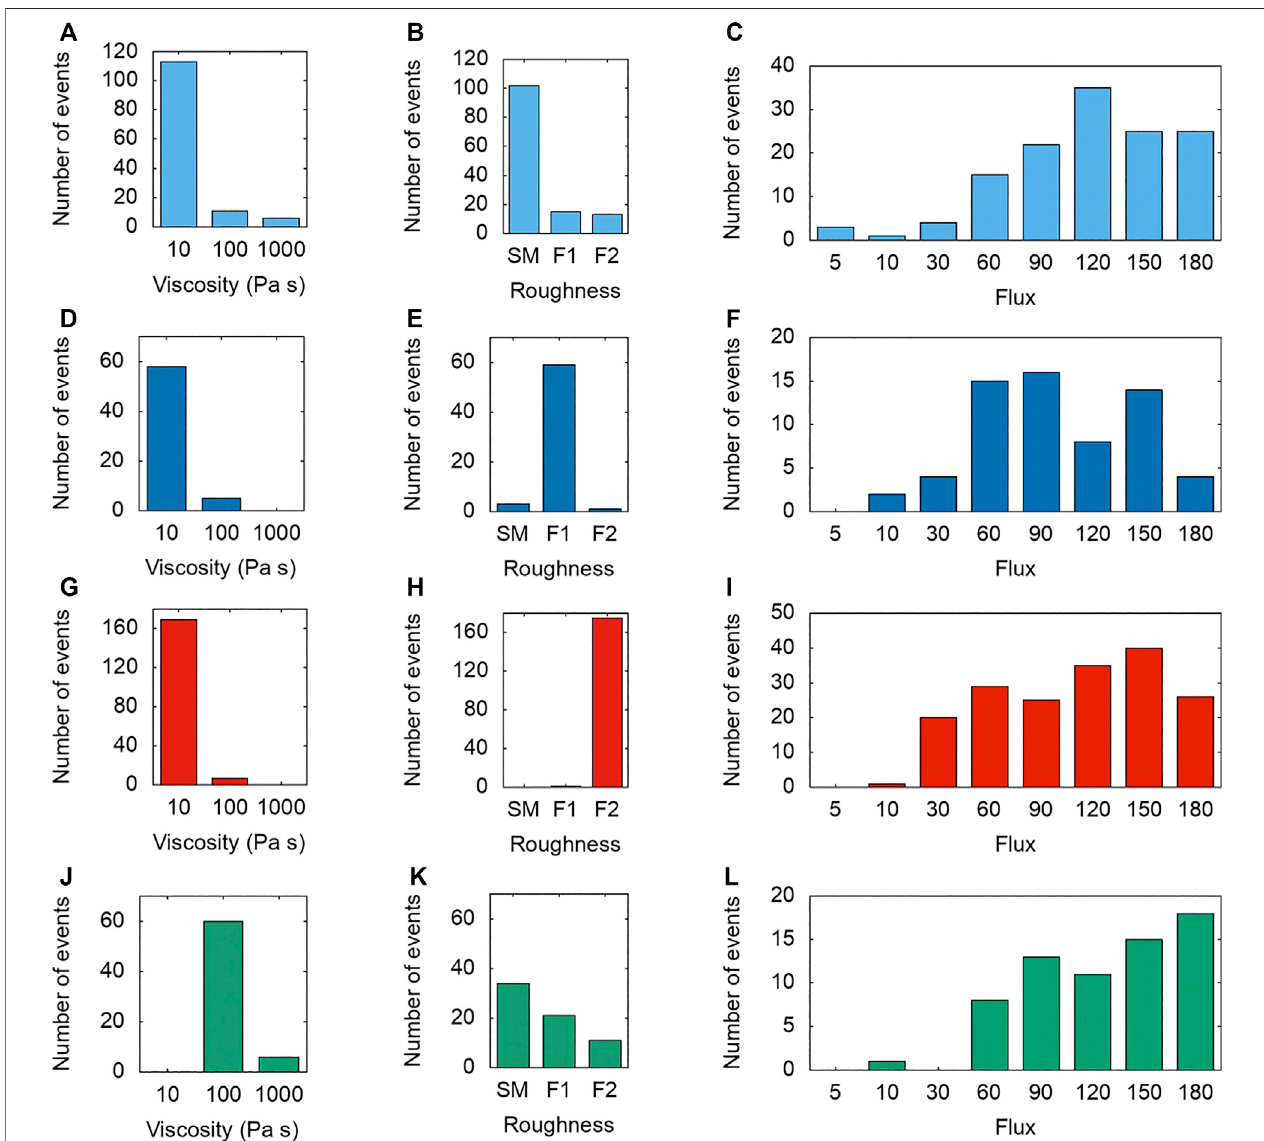
FIGURE 8 | Histograms of the distribution of Cluster 1 (cyan), Cluster 2 (blue), Cluster 3 (red) and Cluster 4 (green) events in the analogue magma viscosity, analogue conduit roughness and fl ux rate classes. Plots (A) , (D) , (G) , and (J) show the distribution of events belonging to the four clusters in the classes of viscosity, expressed in Pa s (B) , (E) , (H) , and (K) represent the conduit roughness classes (SM: smooth; F1: FD (cid:2) 2.18; F2: FD (cid:2) 2.99). The fl ux rate (expressed in 10 – 3 l/s) histograms are shown in (C) , (F) , (I) , and (L) plots.